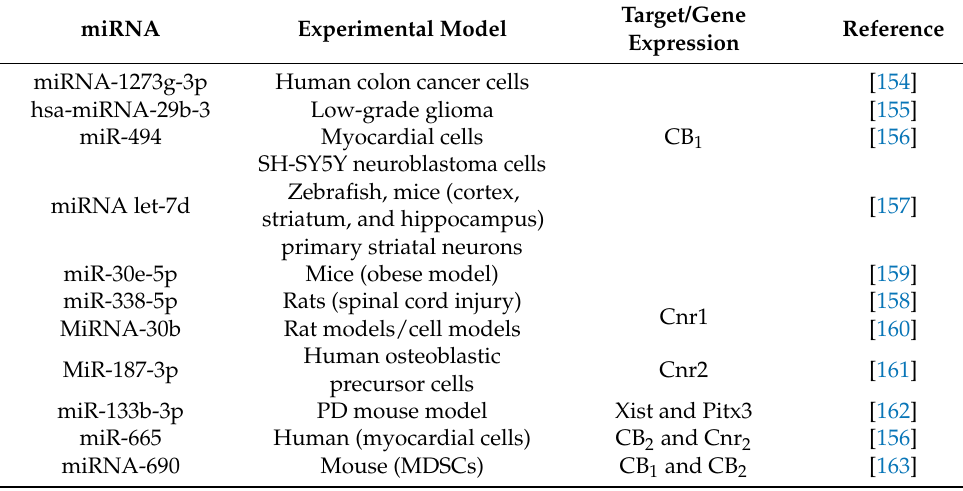
Table 3. miRNA changes related to cannabinoid receptor gene expression. miRNA Experimental Model